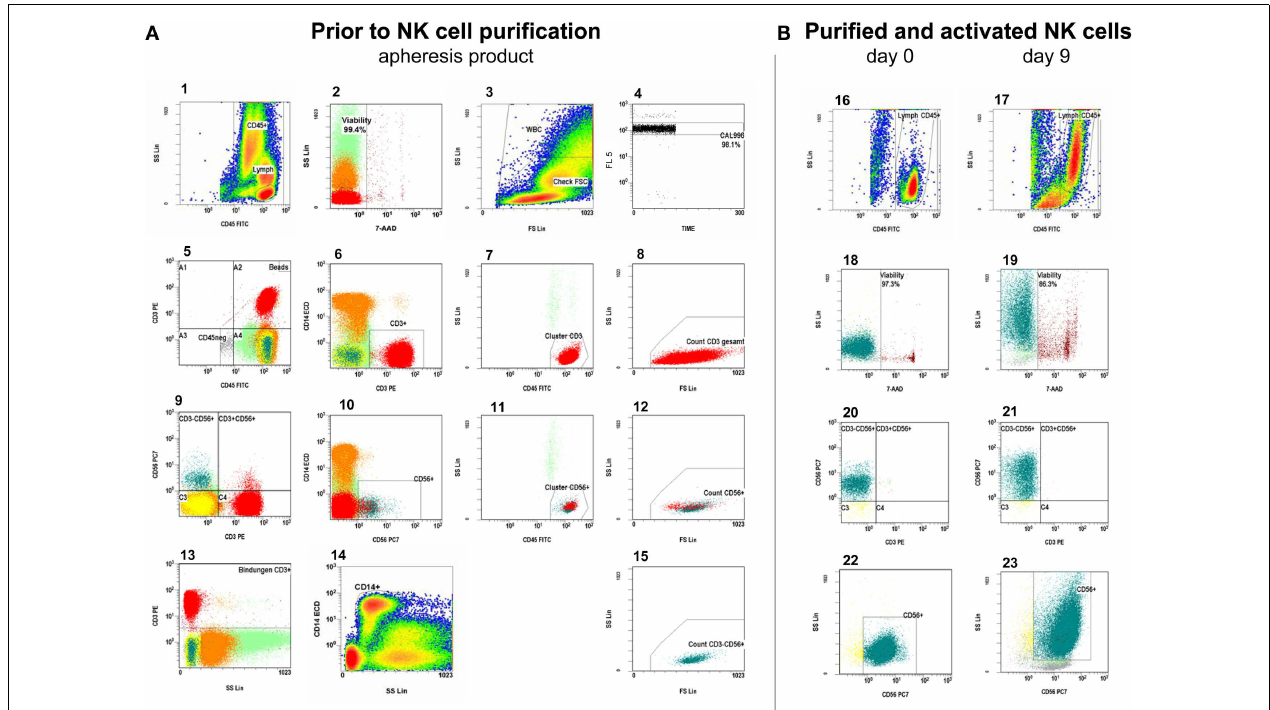
region includes all viable CD3 + or CD56 + leukocytes and is gated on the CD45 + region in plot 1. Plot 7 and plot 11: logical AND linkage (intersection) of regions CD45 + (plot 1), CD3 + or CD56 + (plots 6, 10) and viability (plot 2).The cluster region is set to include CD45 high SC low CD45 + , 7-AAD − CD3 + or CD56 + events, respectively and to exclude granulocytes. Plot 8, plot 12, and plot 15: intersection of the regions from the regions in plots 1, 2, 6 or 10, and 7 or 11, respectively.The respective region is linked with region check FSC (plot 3) so that changes in the position of region check FSC will automatically be adopted by region in the plots of 8, 12, and 15. Region FSC is used to set the lowest limit for FSC.The thus accepted viable CD3 + T cells (plot 8), viable CD56 + NK and NK likeT cells (plot 12), and the viable CD56 + CD3 − NK cells (plot 15) are counted in regions of the plots 8, 12, and 15, respectively. Plot 13: control gate for showing all, specific and unspecific CD3 antibody binding for the calculation of sufficient CliniMACS CD3 reagent for the CD3 depletion of the NK cells. Plot 14: this is used for both enumeration of CD14 + monocytes and as dump channel to exclude monocytes from all analyses, which is of major importance to evaluate residualT cells after NK cell purification. (B) . Respective analyses in the purified NK cell products as well as cultured, expanded NK cells: plot 16 and plot 17: the region is set to include all CD45 + events in accordance to plot 1. Plot 18 and plot 19: discrimination between viable and dead cells in accordance to plot 2. Plot 20 and plot 21: overview of CD56 + CD3 − NK cells, residual CD3 + CD56 − T cells, and CD56 + CD3 + NK likeT cells in accordance to plot 9. Plot 22 and plot 23: the region includes all viable CD56 + CD3 − NK cells gated on the CD45 + region (plot 16, 17).